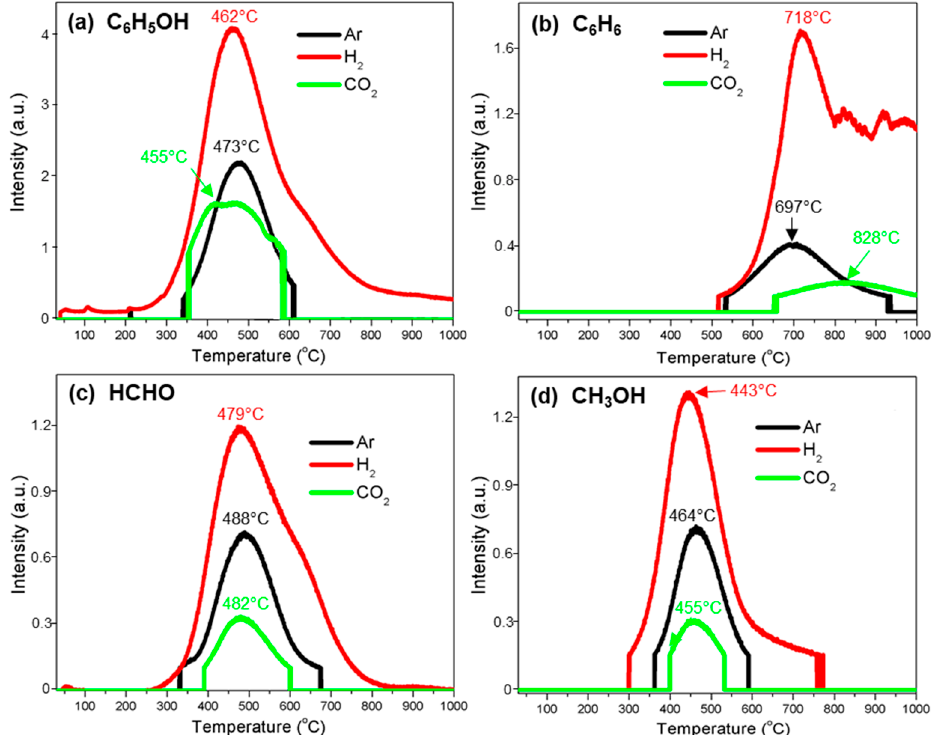
Figure 4. Gas evolution profiles of the thermal decomposition of kraft lignin under argon (Ar), hydrogen (H 2 ), and carbon dioxide (CO 2 ) atmospheres: ( a ) C 6 H 5 OH; ( b ) C 6 H 6 ; ( c ) HCHO; and ( d ) CH 3 OH.